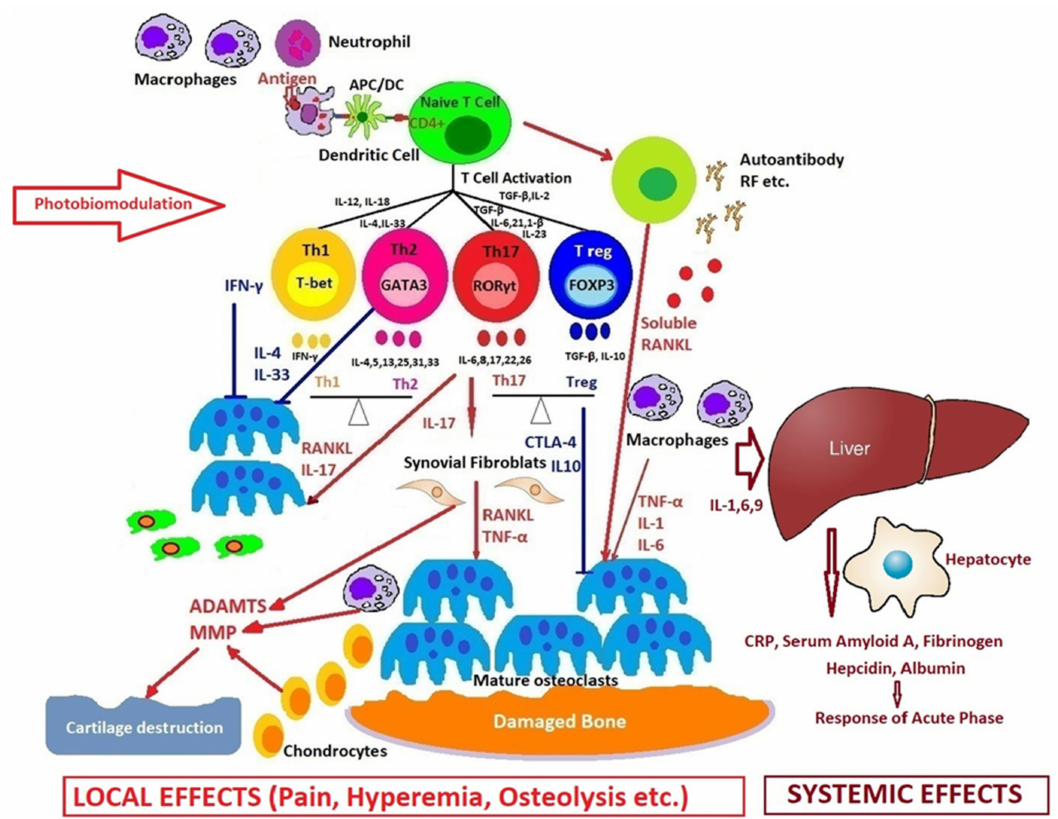
Figure 5. How photobiomodulation could regulate the immune response in arthritis. Possible mechanisms of action on excessive T cell immune response, regulation of pro- and anti-inflammatory cytokines balance, and the process of stopping the proliferative synovium and the osteocartilaginous